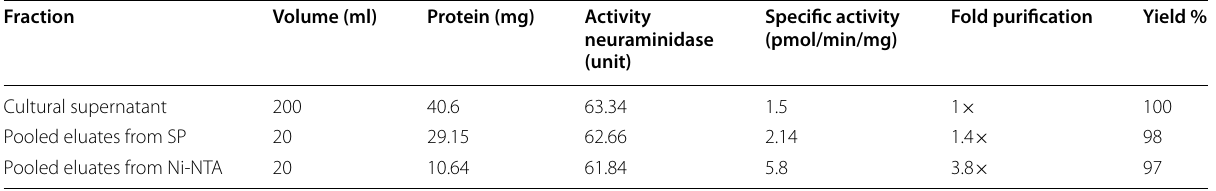
*Specific activity (activity enzyme/protein) = **Fold purification (specific activity/starting special activity) = ***Yield [(activity enzyme/starting activity enzyme) =